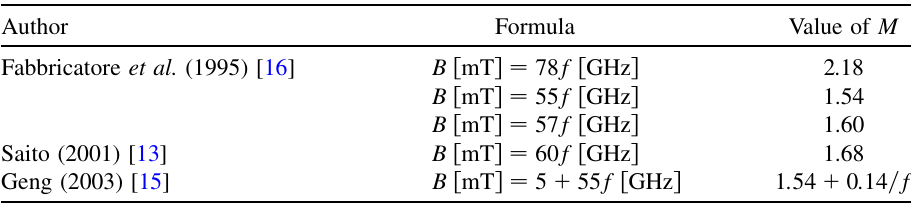
TABLE II. Experimental formulas for the multipacting fields and corresponding values of M .